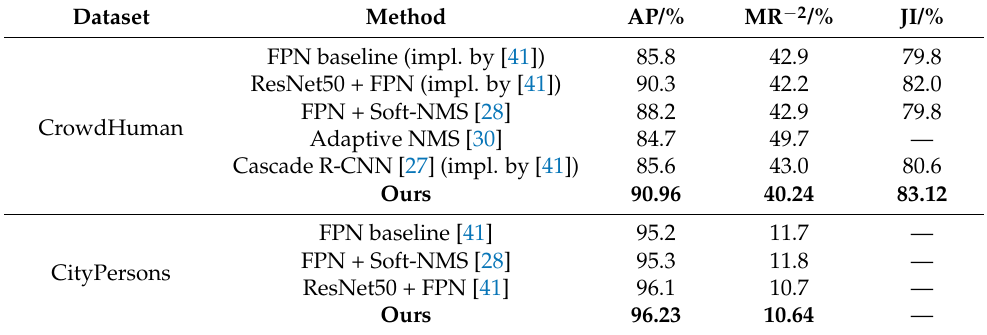
Table 3. Comparisons with previous methods on the CrowdHuman and CityPersons